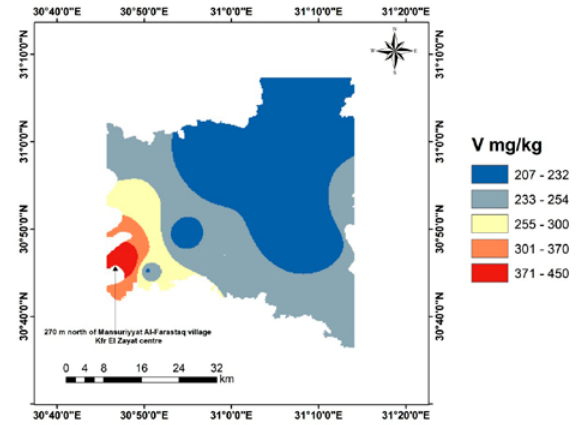
Fig. 4. Spatial interpolation of the weighted mean of